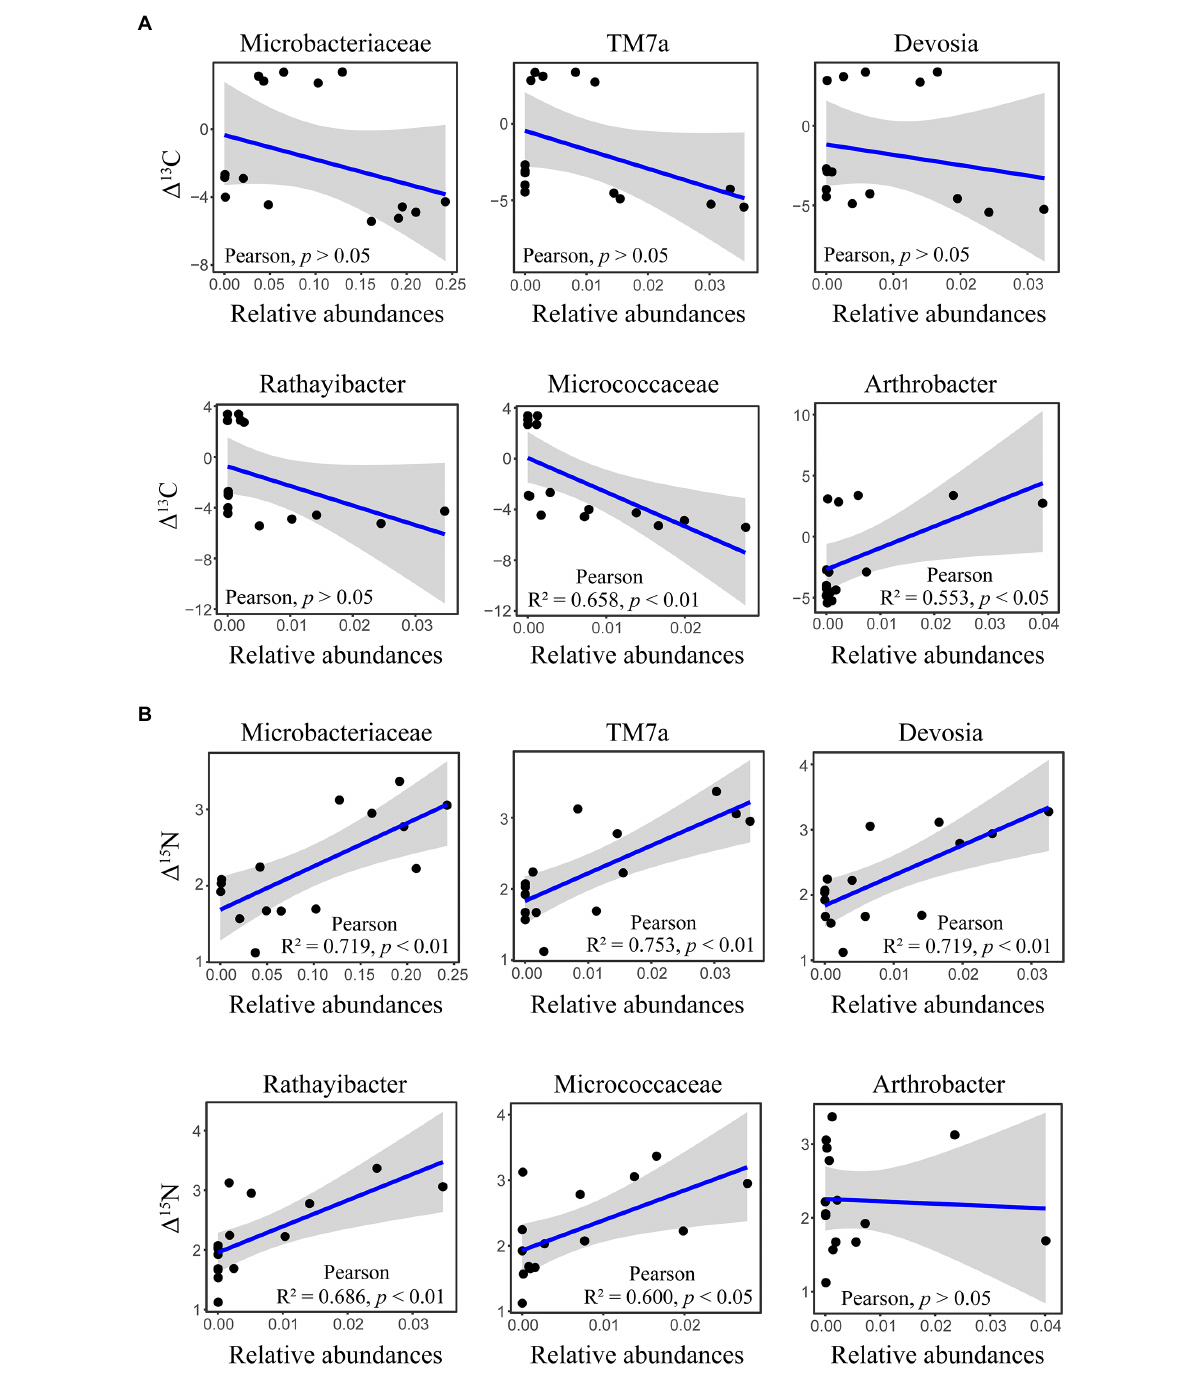
FIGURE 6 Correlation between important microbial genera and stable isotopic enrichment in cold-adapted Collembola. Panel (A) shows correlation between the relative abundance of Microbacteriaceae , TM7a, Devosia , Rathayibacter , Micrococcaceae , and Arthrobacter , and δ 13 C enrichment in Collembola. Panel (B) shows correlation between relative abundance of Microbacteriaceae , TM7a, Devosia , Rathayibacter , Micrococcaceae , and Arthrobacter , and δ 15 N enrichment in